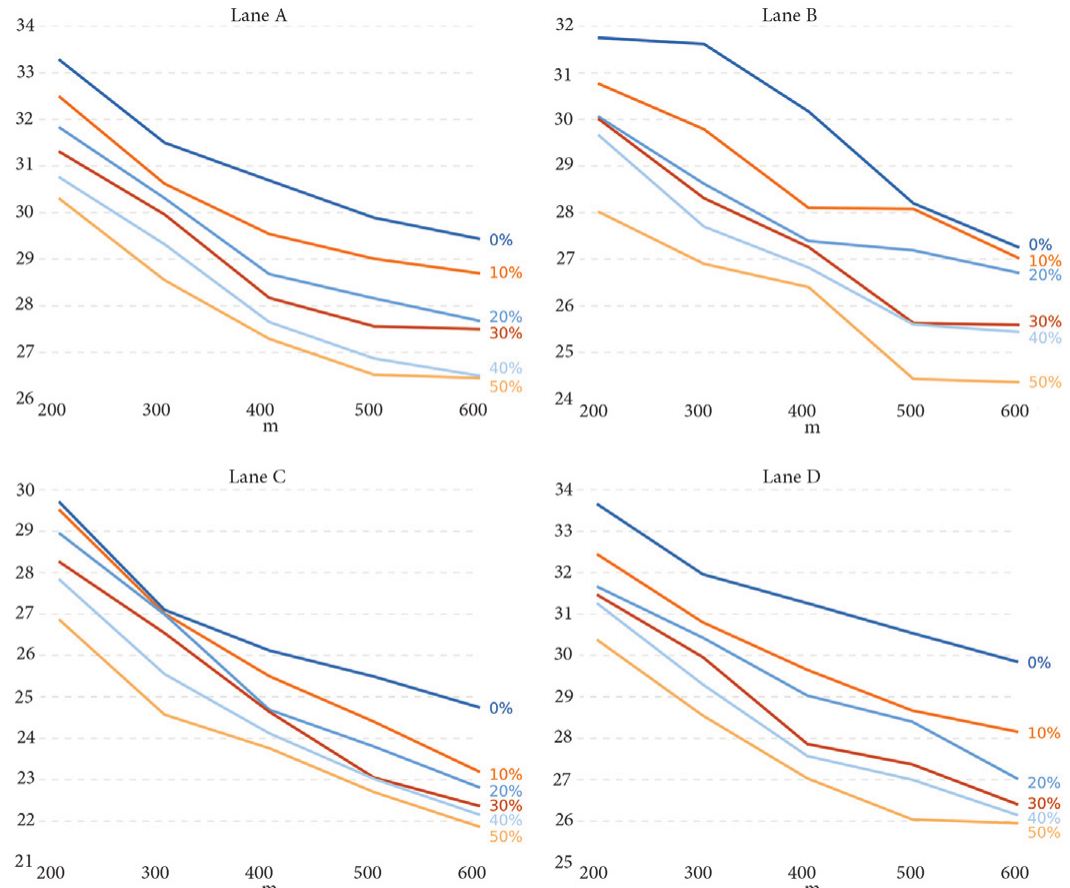
Fig. 7. Loads in kN/m calculated using the first